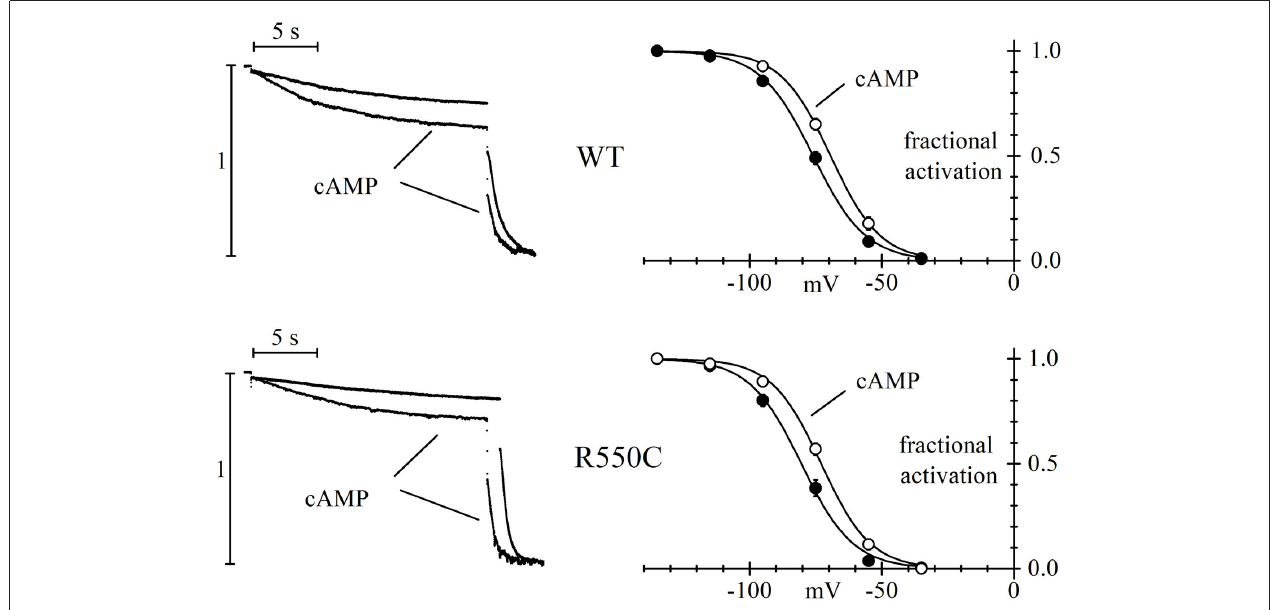
FIGURE 3 | The R550C mutation does not affect the cAMP dependence of HCN4 channels. Representative current traces recorded during steps to − 75/ − 125 mV from a hp of − 35 mV (left) and mean activation curves (right) in CHO cells expressing WT (top) or R550C mutated channels (bottom). Records and activation curves labeled “cAMP” were obtained with patch pipettes filled with the standard intracellular-like solution to which 10 µ m cAMP was added. Sample traces on the left are normalized to maximal amplitude at − 125 mV. cAMP shifted the hHCN4 channel activation curve by 7.5 and 7.2 mV in WT and R550C-expressing cells, respectively. V 1 / 2 and s values from Boltzmann fitting were (mV): WT, − 76.7 ± 1.4, 9.41 ± 0.49 ( n = 16); WT+cAMP, − 69.2 ± 1.2, 8.80 ± 0.78 ( n = 16); R550C, − 80.1 ± 1.6, 8.72 ± 0.59 ( n = 14); R550C+cAMP, − 72.9 ± 1.1, 9.02 ± 0.51 ( n =